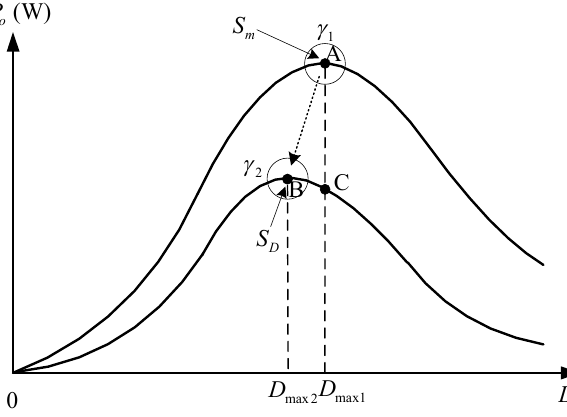
Figure 6. Characteristics of the MPP moving with the decreasing irradiance. Table 5. Simulation results under decreasing irradiance conditions.